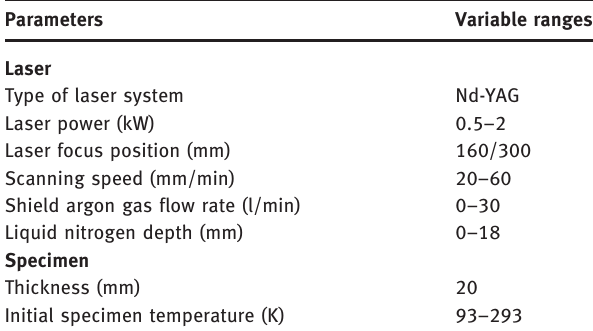
Table 2: Laser surface melting conditions. Parameters Variable